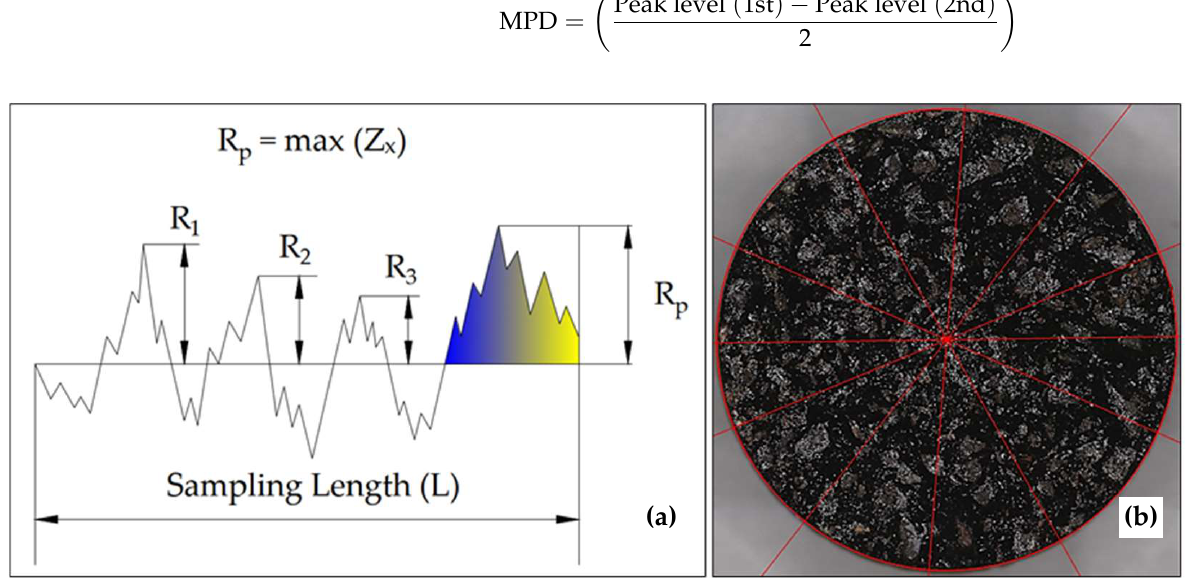
Figure 3. ( a ) Maximum profile peak height (Rp) ( left ); ( b ) PAM specimen with divided segments ( right ).